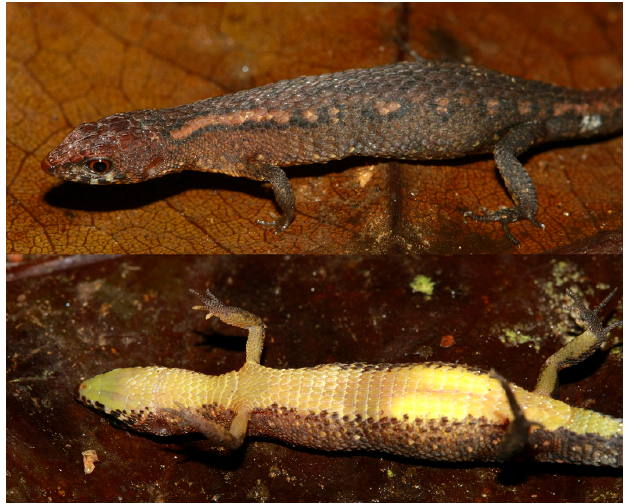
Amapasaurus tetradactylus Adult female eggs and the characteristic four digits. Photographs by Maël